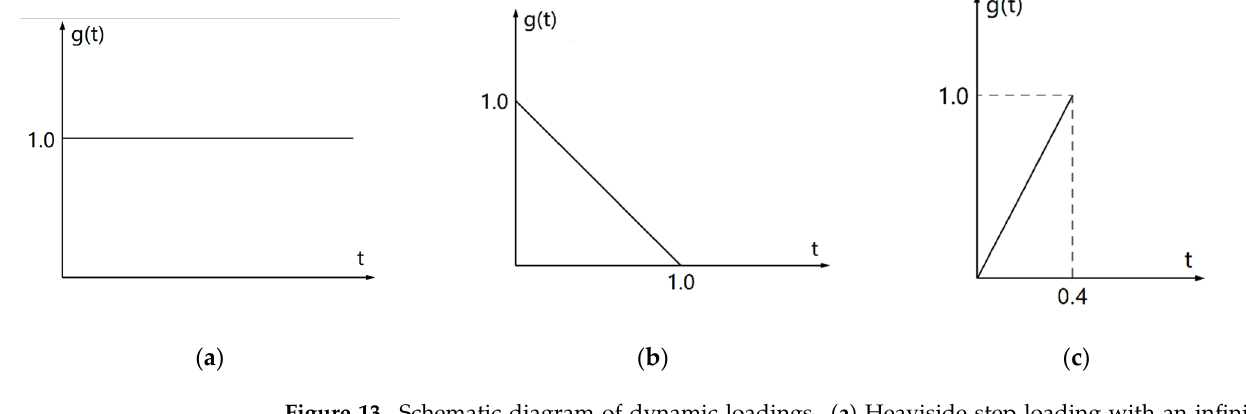
Figure 13. Schematic diagram of dynamic loadings. ( a ) Heaviside step loading with an infinite duration; ( b ) transient loading with a finite decreasing time; ( c ) transient loading with a finite increasing time.